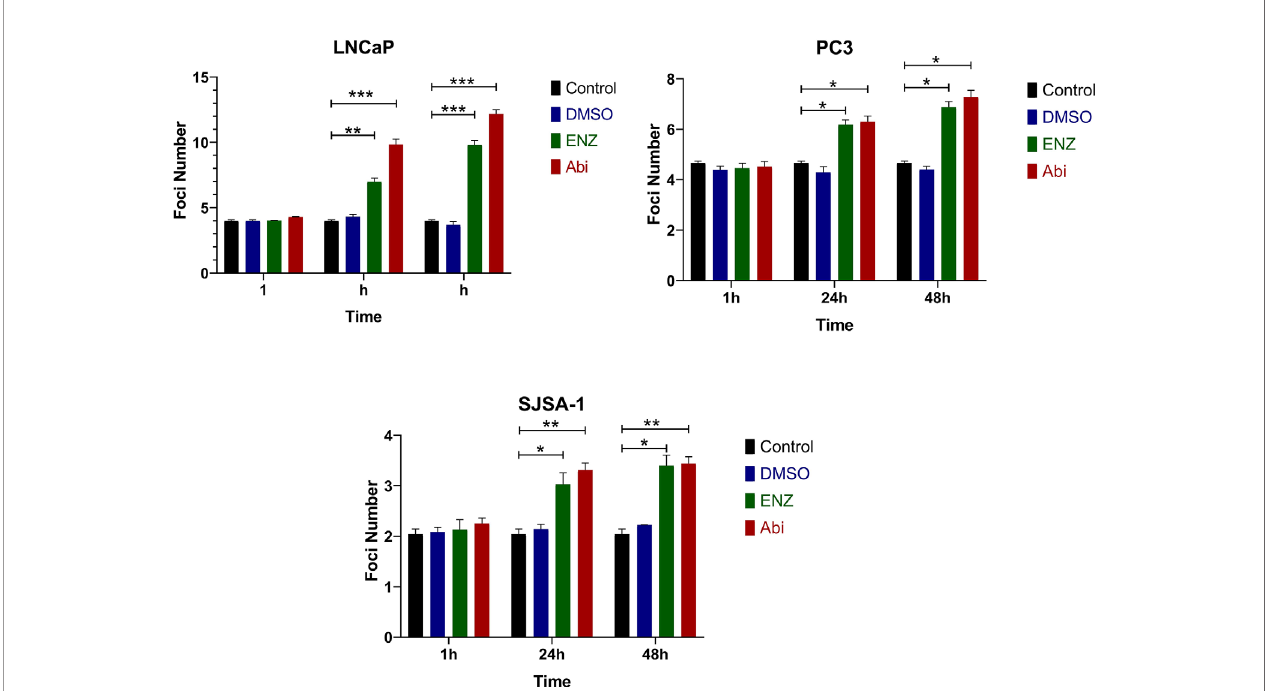
FIGURE 5 | Immuno fl uorescence of 53BP1 foci treated with Abiraterone and Enzalutamide on AR-insensitive PC3s and AR-sensitive LNCaP prostate models and osteoblastic bone model SJSA-1. All models were treated with 10 m M Abiraterone, Enzalutamide or DMSO and harvested 1-, 24 and 48-hours post-treatment before being fi xed and stained with 53BP1 (n=3). Unpaired students t-test was used for comparisons between two groups *p ≤ 0.05, **p ≤ 0.01, ***p ≤ 0.001, and error bars represent